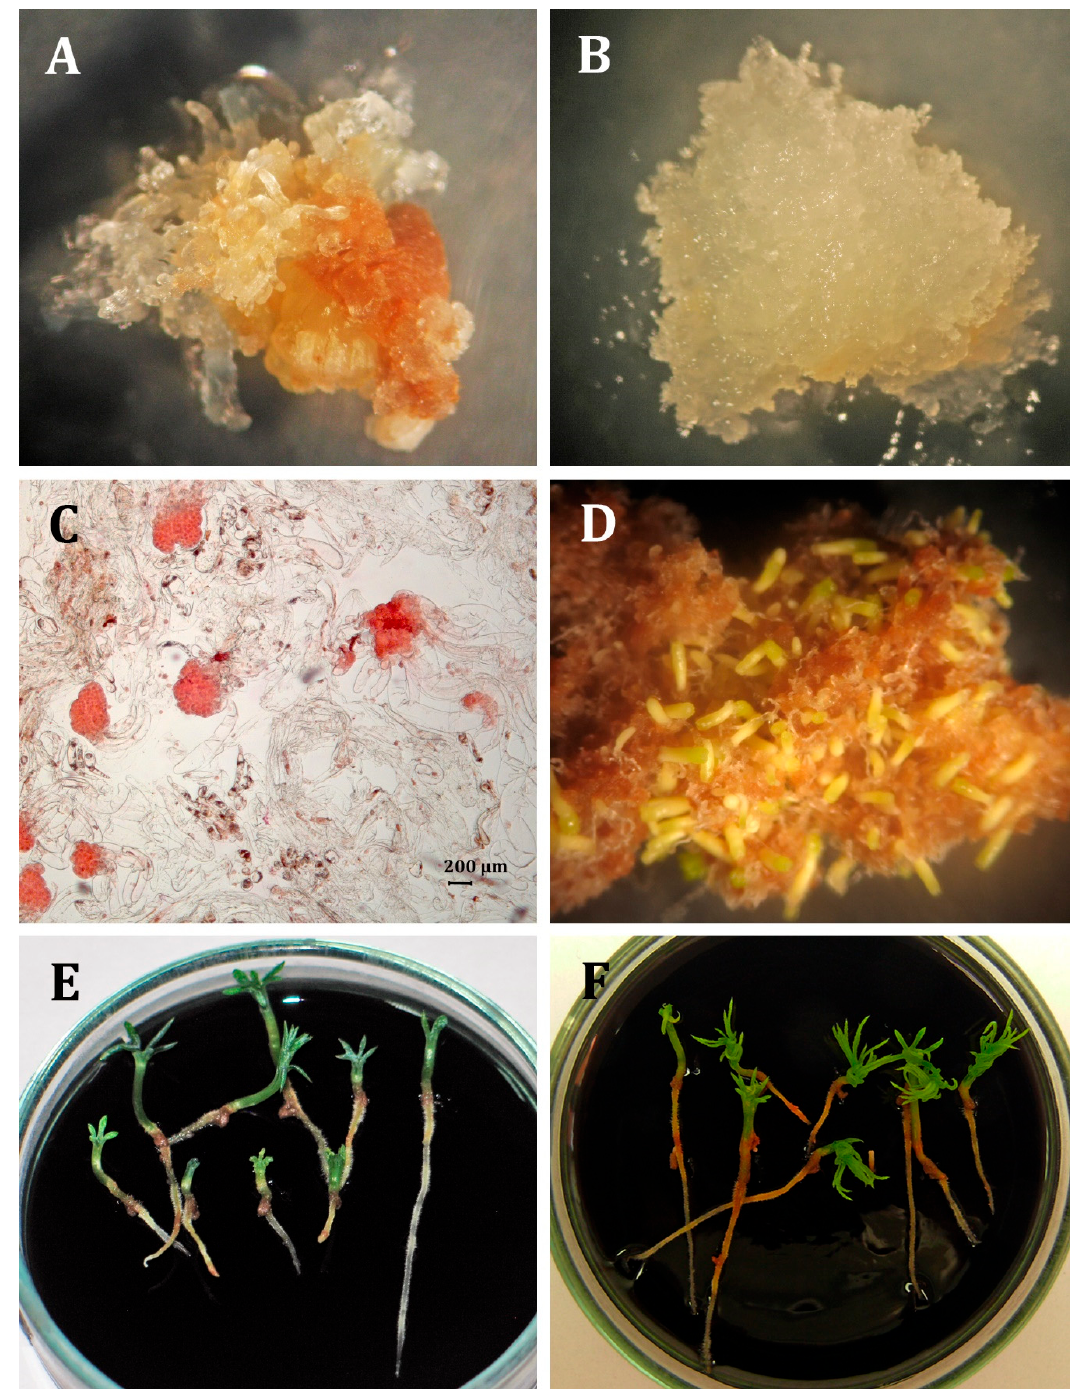
Figure 1. Somatic embryogenesis in P. abies . ( A ) Embryogenic masses developed on the explant. ( B ) Embryogenic cultures growing on the proliferation medium. ( C ) Proembryogenic structures (proembryos) present in the embryogenic tissues. ( D ) Somatic embryos going through the maturation process. ( E ) Germinated somatic embryos. ( F ) Somatic seedlings with developed first needles suitable for